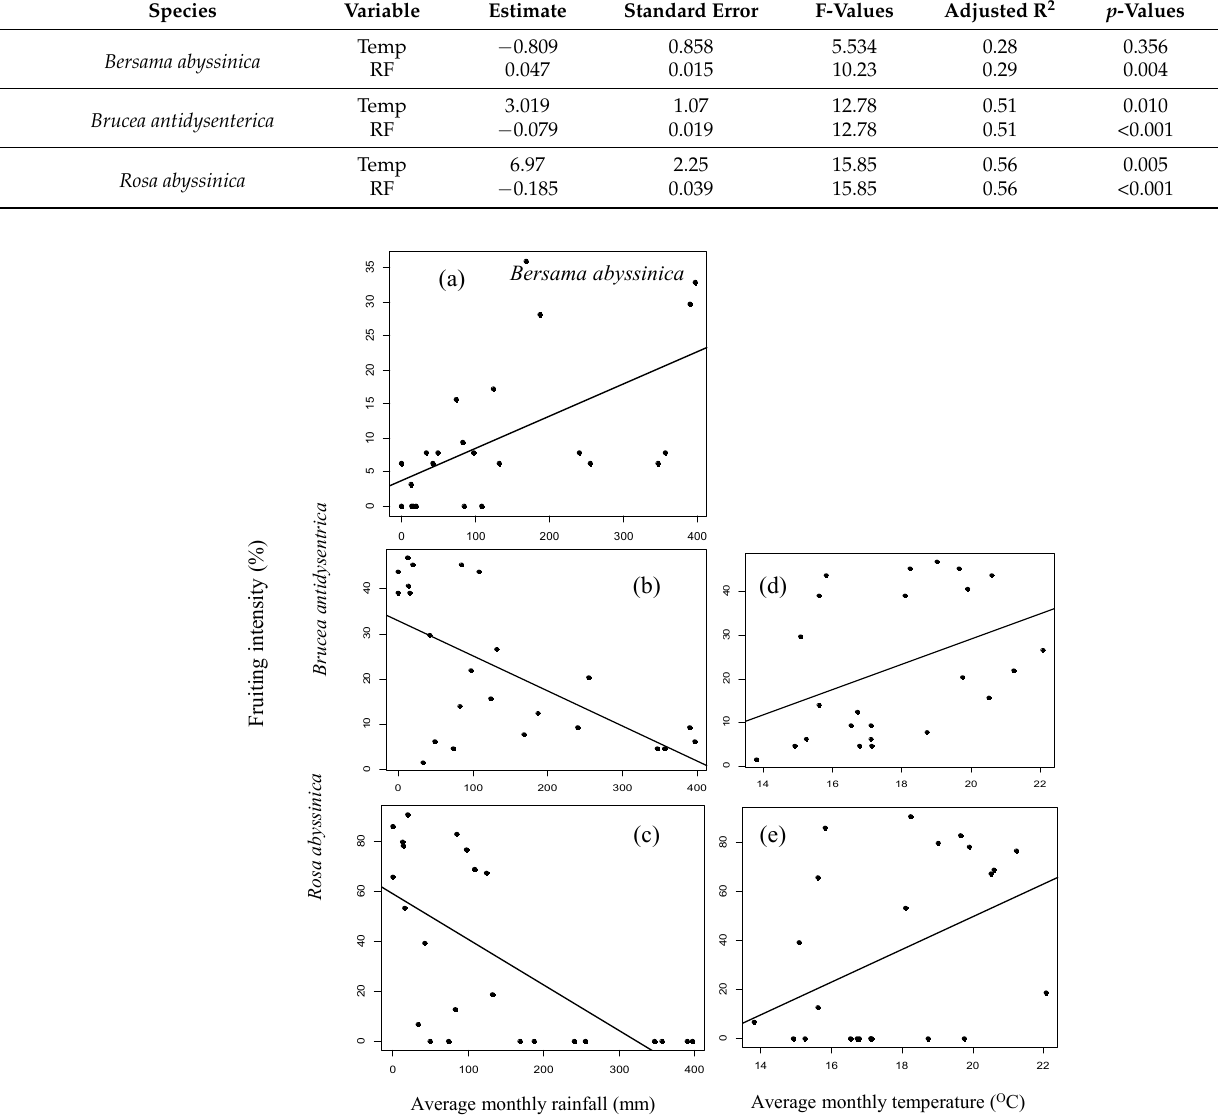
Figure 11. The line graph showing the fruiting intensity in relation to mean monthly temperature and monthly rainfall: ( a ) Bersama abyssinica , ( b , d ) Brucea antidysenterica , ( c , e ) Rosa abyssinica. The results of the non ‐ linear quadratic polynomial regression model analyses indi ‐